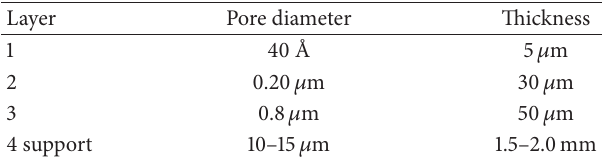
Table 2: Membrane characteristics.